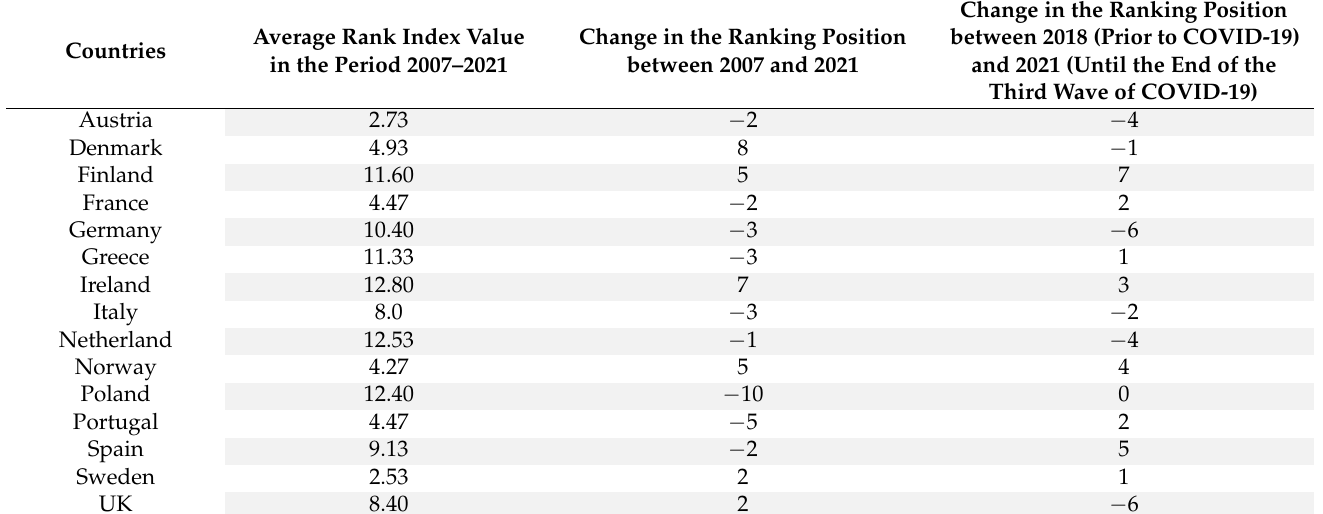
Table 2. The average value of the Rank index for the 2007–2021 period.